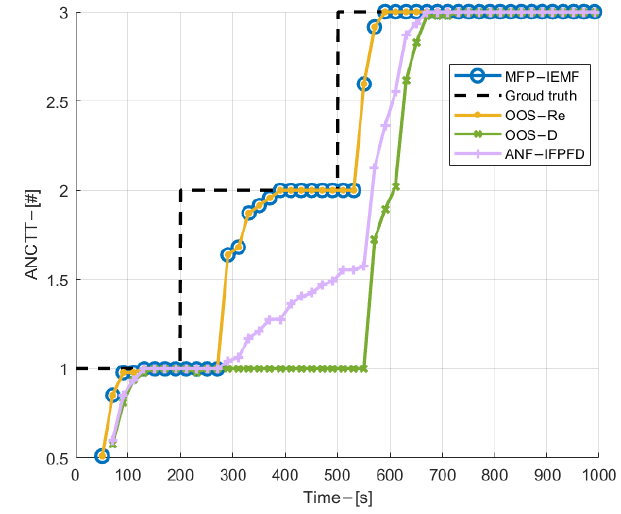
Figure 6. ( a ) Position estimation RMSE of submarine 1 in experiment 1; ( b ) velocity estimation RMSE for submarine 1 in experiment 1; ( c ) position estimation RMSE of submarine 2 in experiment 1; ( d ) velocity estimation RMSE for submarine 2 in experiment 1; ( e ) position estimation RMSE of subma- rine 3 in experiment 1; ( f ) velocity estimation RMSE for submarine 3 in experiment 1.